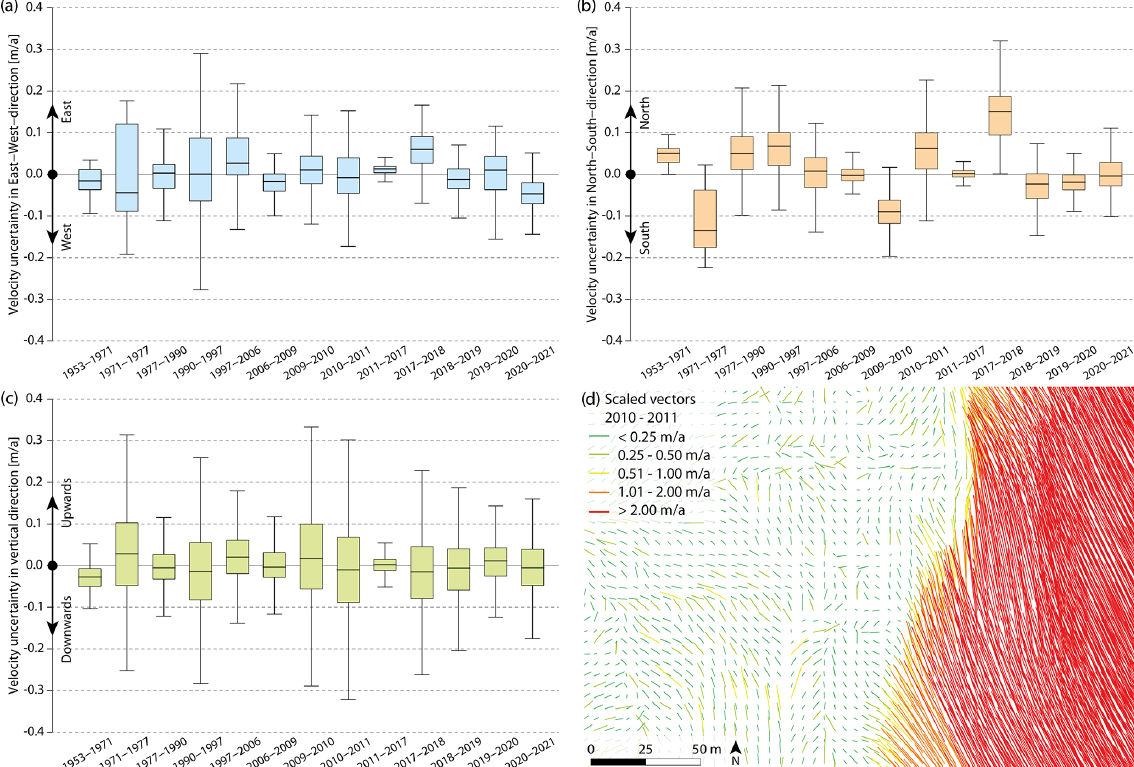
Figure 15. Uncertainty of velocity vectors based on analysis of vectors on stable ground surrounding the rock glacier for each DSM pair in the east–west direction (a) , the north–south direction (b) , and vertically (c) . The boxplots show the median, the interquartile range (box), and up to 1.5 times the interquartile range (whiskers). Outliers are not shown. An example of the resulting velocity vectors (20-fold exaggeration used for visualization purposes) for the period 2010 to 2011 within and outside of the rock glacier area is shown in (d) . Derived vectors on the rock glacier (yellow, orange, and red colours) agree well in terms of their direction, while on surrounding stable ground vectors of minor length and random direction (green colours) can be